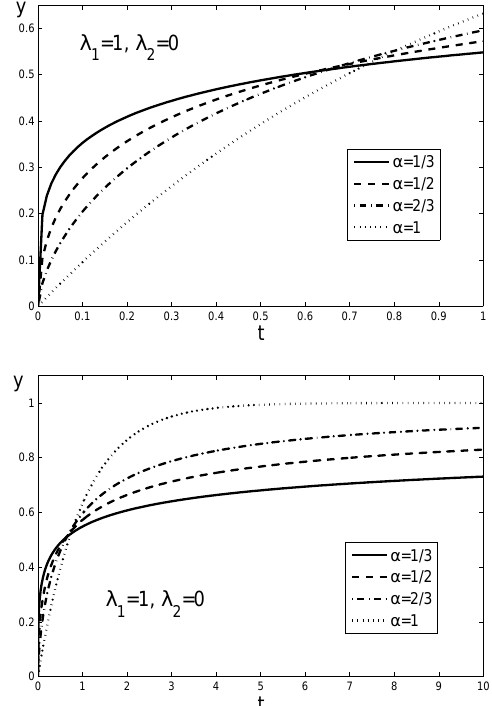
Fig. 1. Time profile of the pressure gradient for A = 1 , λ 1 = 1 , λ 2 = 0 , and various values of α . Time interval [0 , 1] (above) and [0 , 10]